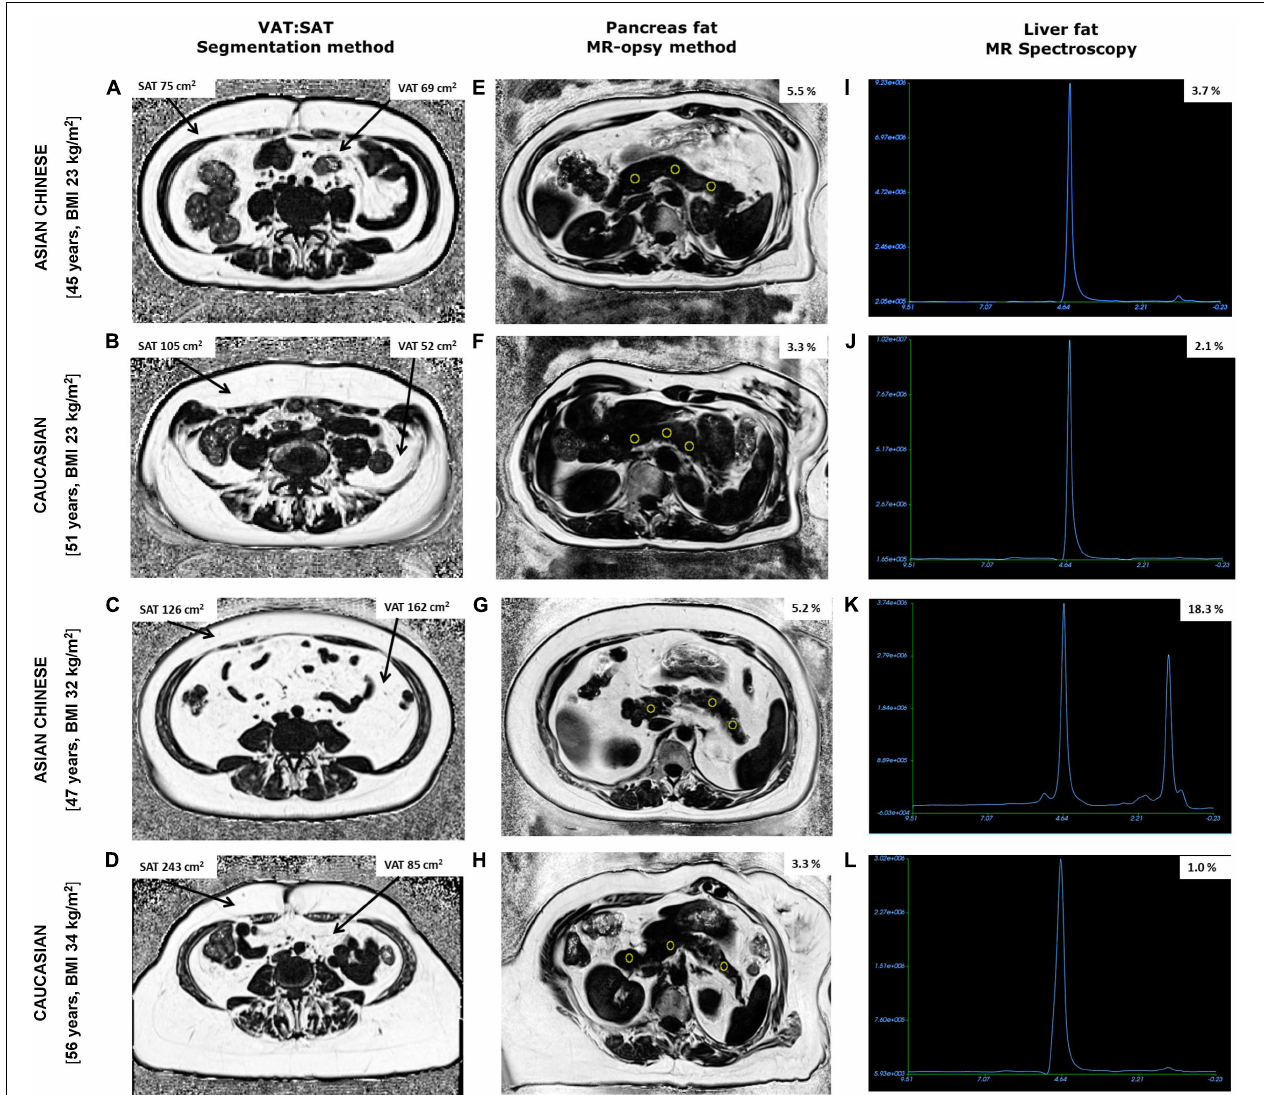
FIGURE 2 | Fat fraction maps obtained from abdominal MRI scans showing subcutaneous (SAT), visceral adipose tissue (VAT), and pancreas fat along with MR spectroscopy of liver fat from two Chinese and two Caucasian women. Chinese women aged 45 years, BMI 23 kg/m 2 (A,E,I) and 47 years, BMI 32 kg/m 2 (C,G,K) had lower SAT and higher pancreas fat compared to older BMI matched Caucasian women aged 51 years, BMI 23 kg/m 2 (B,F,J) and 56 years, BMI 34 kg/m 2 (D,H,L) , respectively. Notably, VAT, % pancreas and % liver fat were higher in both Chinese women compared with BMI matched Caucasian counterparts exhibiting the TOFI